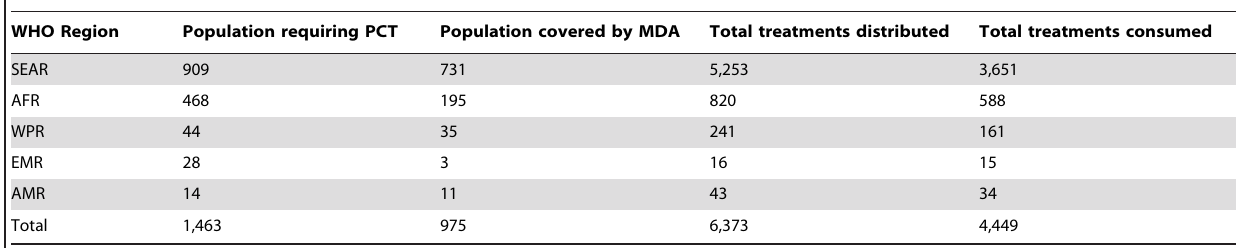
Table 2. Details of treatments given under the MDA programme of GPELF (2000–2012).